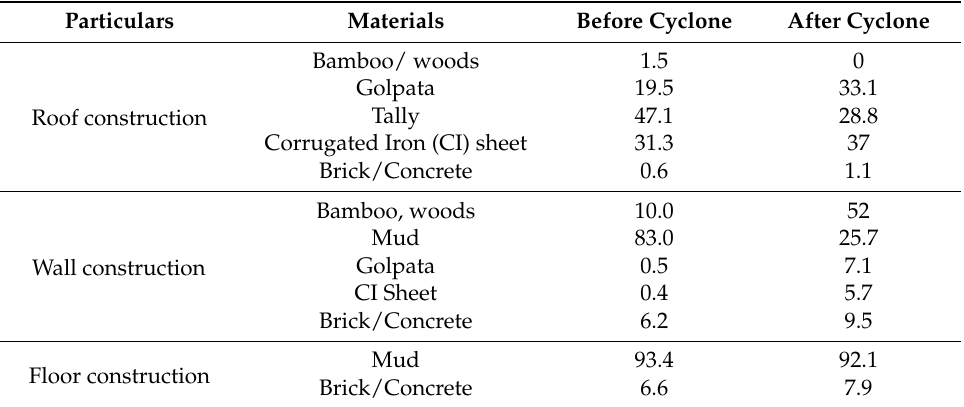
Table 5. Housing construction